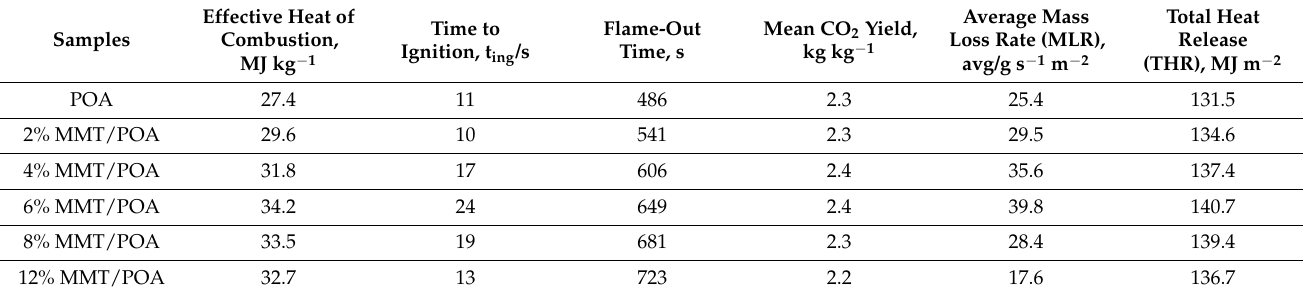
Figure 7. The horizontal burning rate of pure POA blends with MMT clay nanofiller (2, 4, 6, 8, and 12%). Table 3. Cone-calorimeter tests on the heat and ignition characteristics of pure POA and MMT/POA